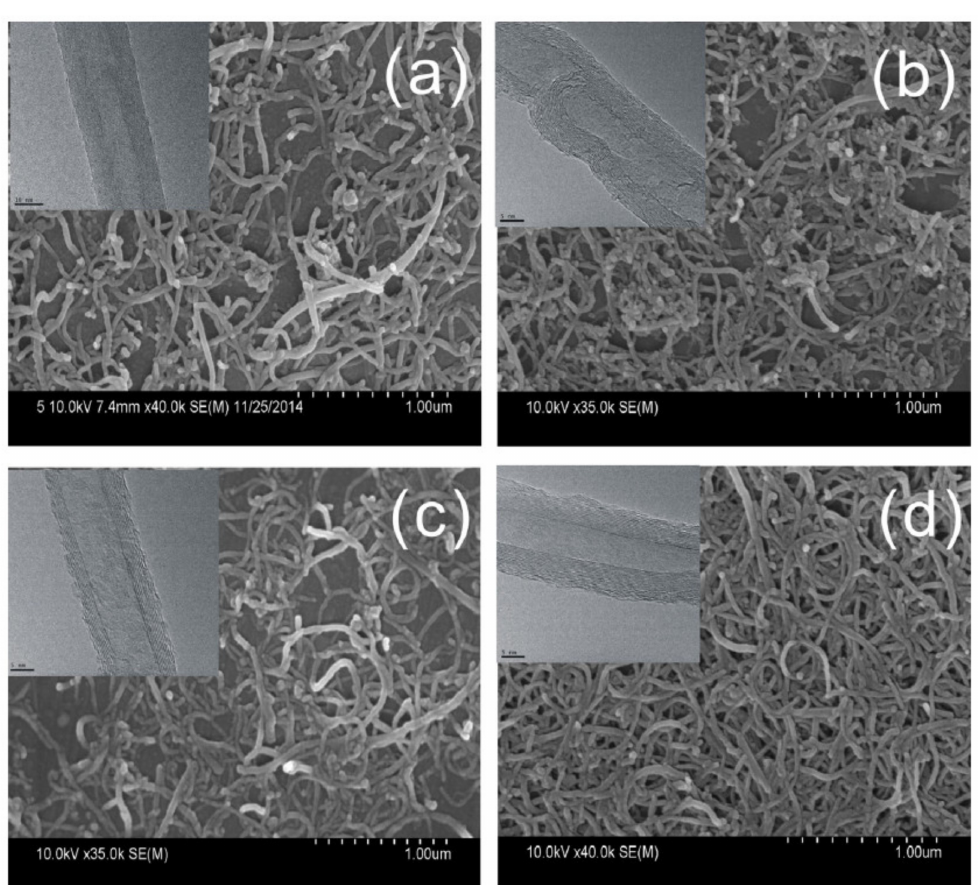
Figure 5. Example of TEM and SEM micrographs; ( a – d ) indicate the effect of different functionalization procedures (acid treatment with ultrasonication) to MWCNT, cited from [15].